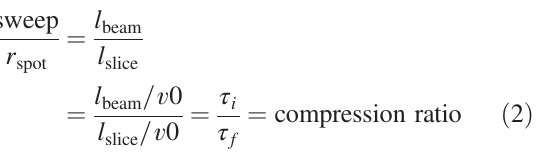
FIG. 4. (a) and (b) show that, for a fixed sweep, the smaller the spot size, the smaller the discrepancy in energy loss within a slice. (a) and (c) show that, for a fixed spot size, the larger the sweep, the smaller the discrepancy in energy loss within a slice.